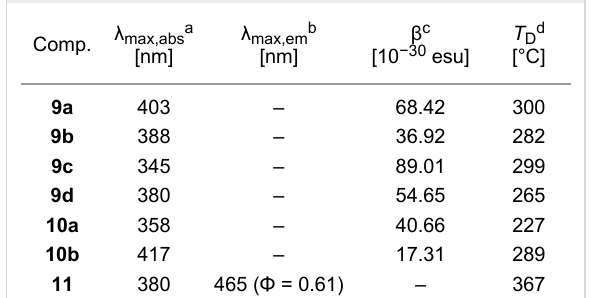
Table 3: Linear and nonlinear optical properties and thermal stabilities of chromophores 9 – 11 [13,15,37].